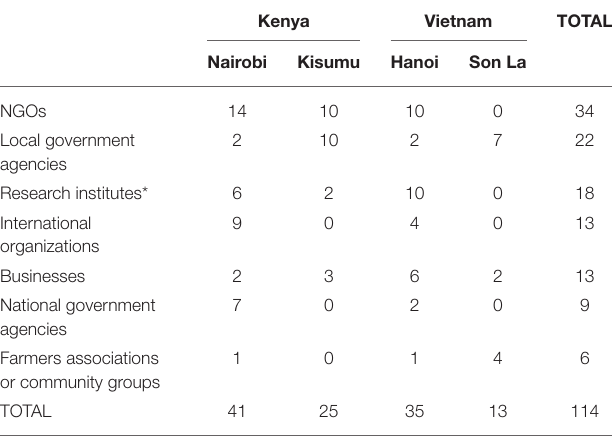
TABLE 1 | Stakeholders interviewed in Kenya and